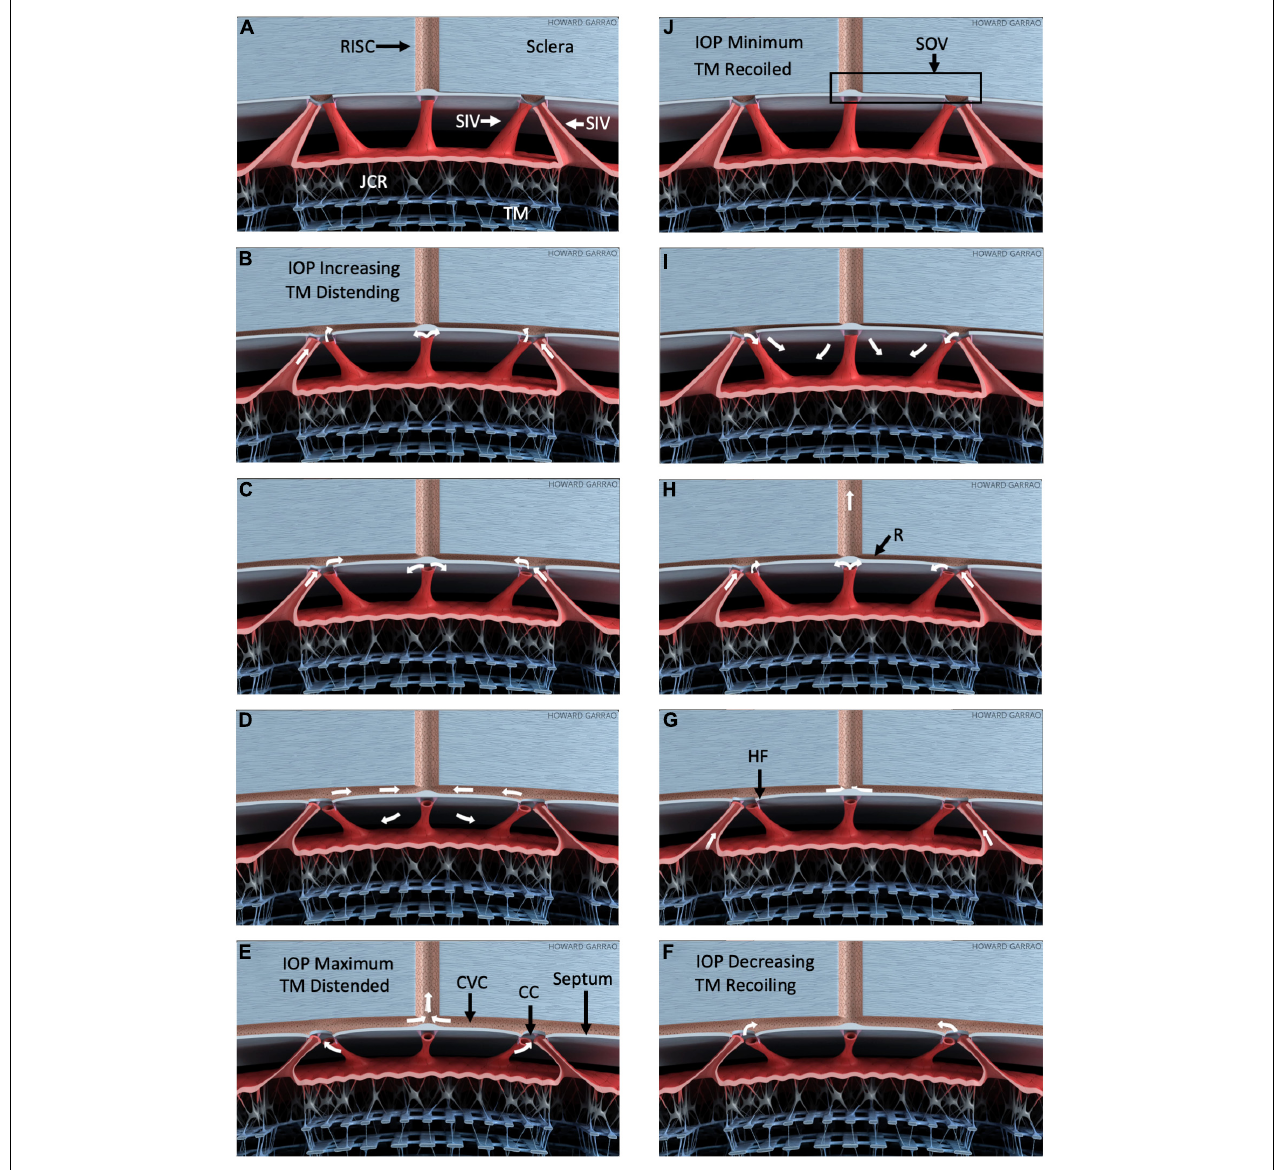
FIGURE 9 | Pressure-dependent outflow system tissue motion and flow. Schematic depiction of outflow structure pressure-dependent motion and related outflow oscillating around a mean setpoint ( Supplementary Video 4 ). (A–E) Depict trabecular meshwork (TM) distention into SC in response to a pressure increase. (F–J) Depict recoil from the distended configuration. As IOP increases (B) , the TM and juxtacanalicular region (JCR) progressively enlarge, decreasing SC dimensions. SIV connect the TM to septa that appear as hinged flaps (HF), where they connect to CC entrances. The SIV is obliquely oriented within the circumference of SC. Outward TM motion can cause the SIV to induce tension on the septa and hinged flaps at collector channels (CC). Thin mobile septa provide a barrier between SC and circumferential vascular channels (CVC) adjacent to the canal. As pressure falls, the CVC progressively closes with a resulting increase in resistance (R), as noted in (H) . The resulting behavior permits the CVC region to act like an SC outlet valve-like structure (SOV). Progressive closure reduces inward flow from SC and outward flow to radially oriented intrascleral vessels (RISC). IOP-dependent TM movement can act as a sensor controlling the SOV configuration, thereby providing a feedback loop to control IOP. Minimal linear TM motion may amplify flow resistance because of Poiseille’s law. White arrows depict one possible aqueous flow sequence. All aspects of the model are provisional and subject to